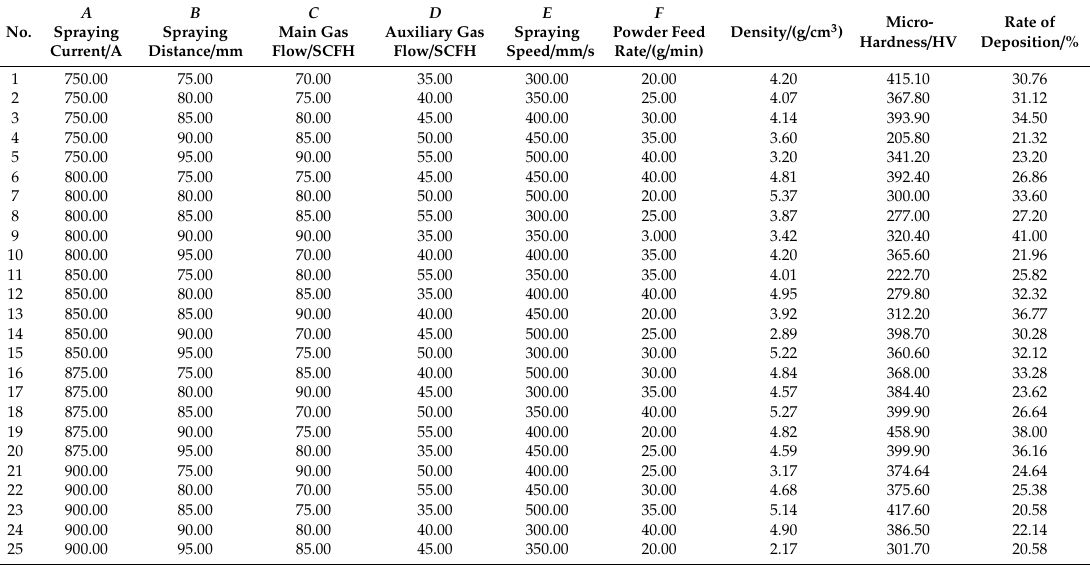
Table 4. L25 (56) orthogonal experiment table with six factors and five levels.